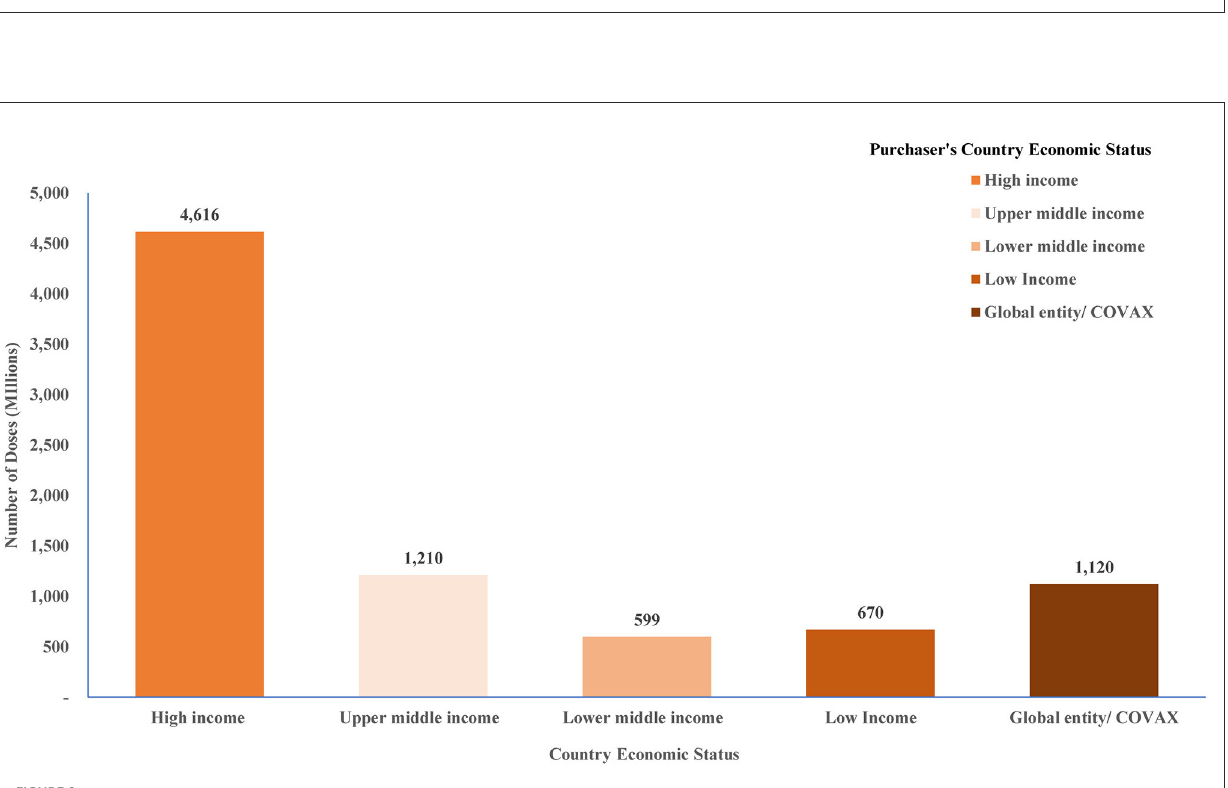
FrontiersinPublicHealth